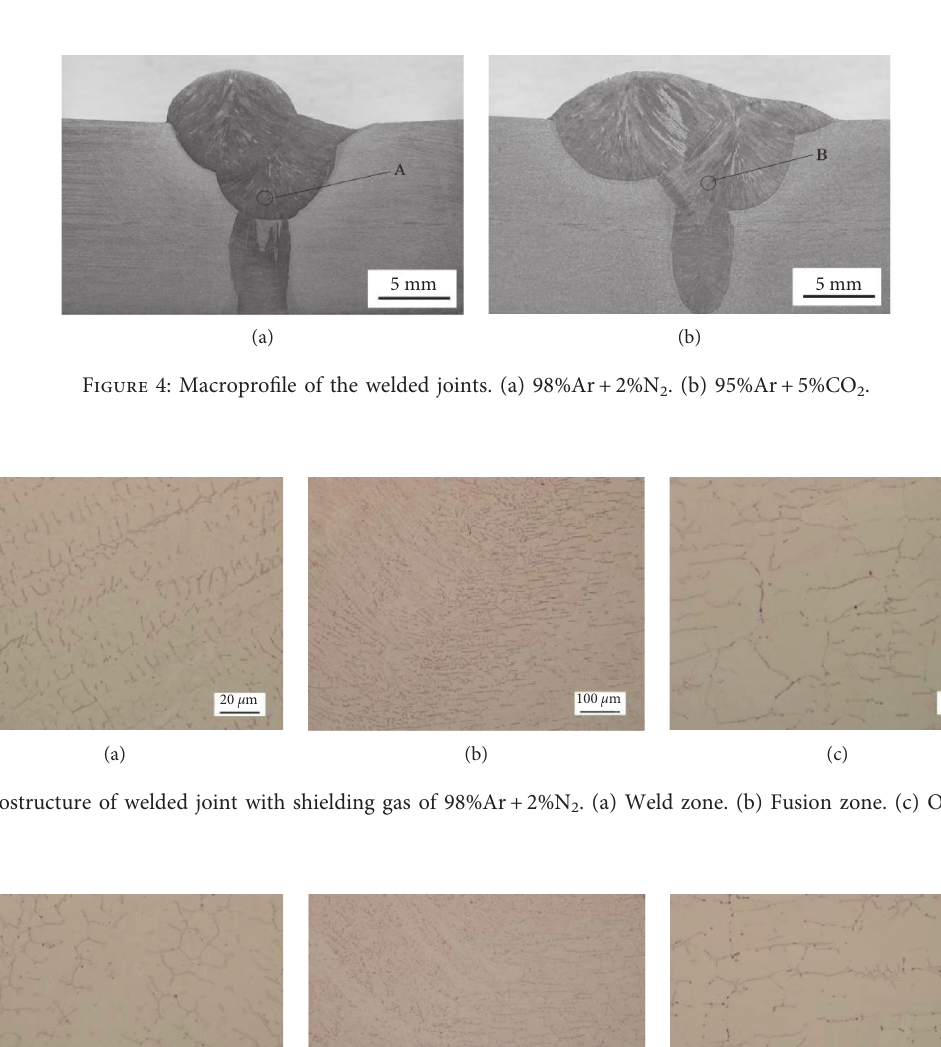
2 . (a). Weld zone. (b) Fusion zone. (c) Overheating zone.